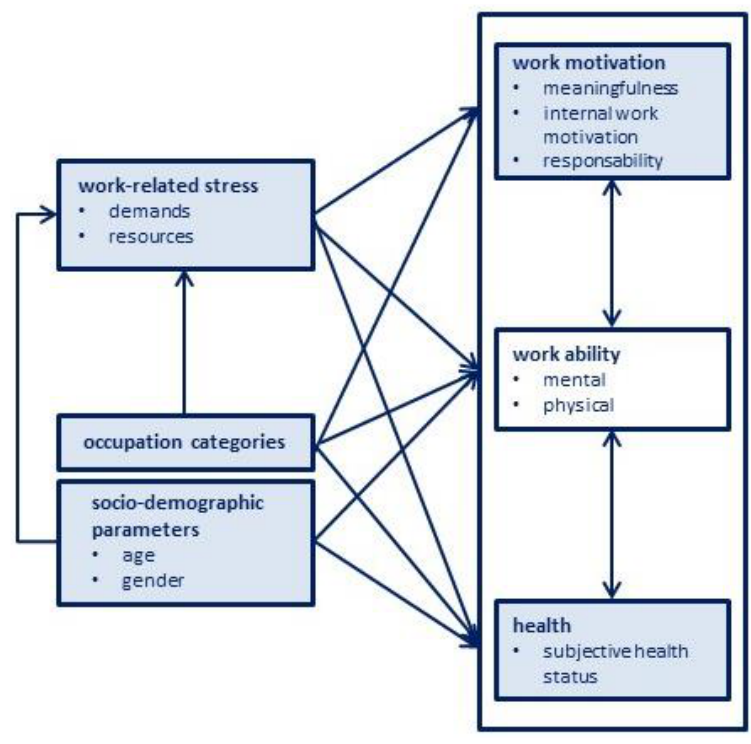
Figure 2. The relation between work motivation and health as affected by the work ability—Expansion to the factors age, gender, occupation categories, and work-related stress.